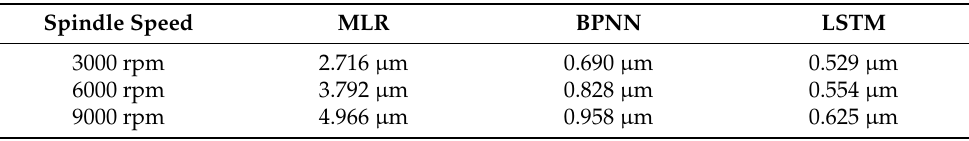
Table 8. RMSEs of the MLR, BPNN, and the proposed LSTM models at different spindle rota- tion